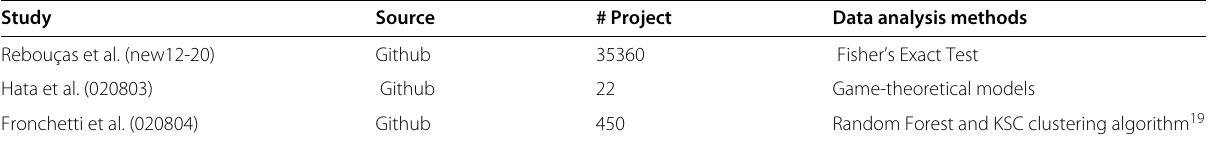
Table 1 Statistics of investigated papers. “Source” denotes where the projects are collected for investigation, “# Project” indicates the number of investigated projects, and “Approach” shows what methods are used to obtain the conclusions ( Continued